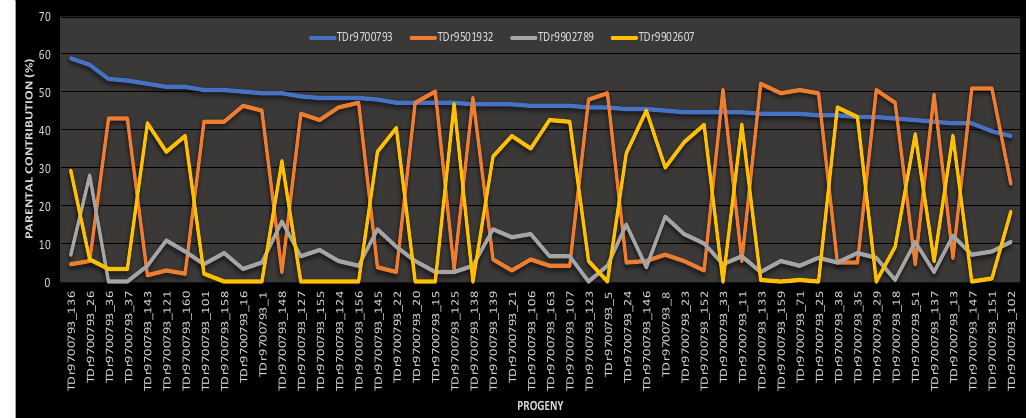
Figure 1. Pedigree reconstruction of polycross family TDr1685 based on genetic contribution of shared parental alleles in progeny . TDr9501932, TDr9902789 and TDr9902607 = male parents; TDr9700793 = female parent.